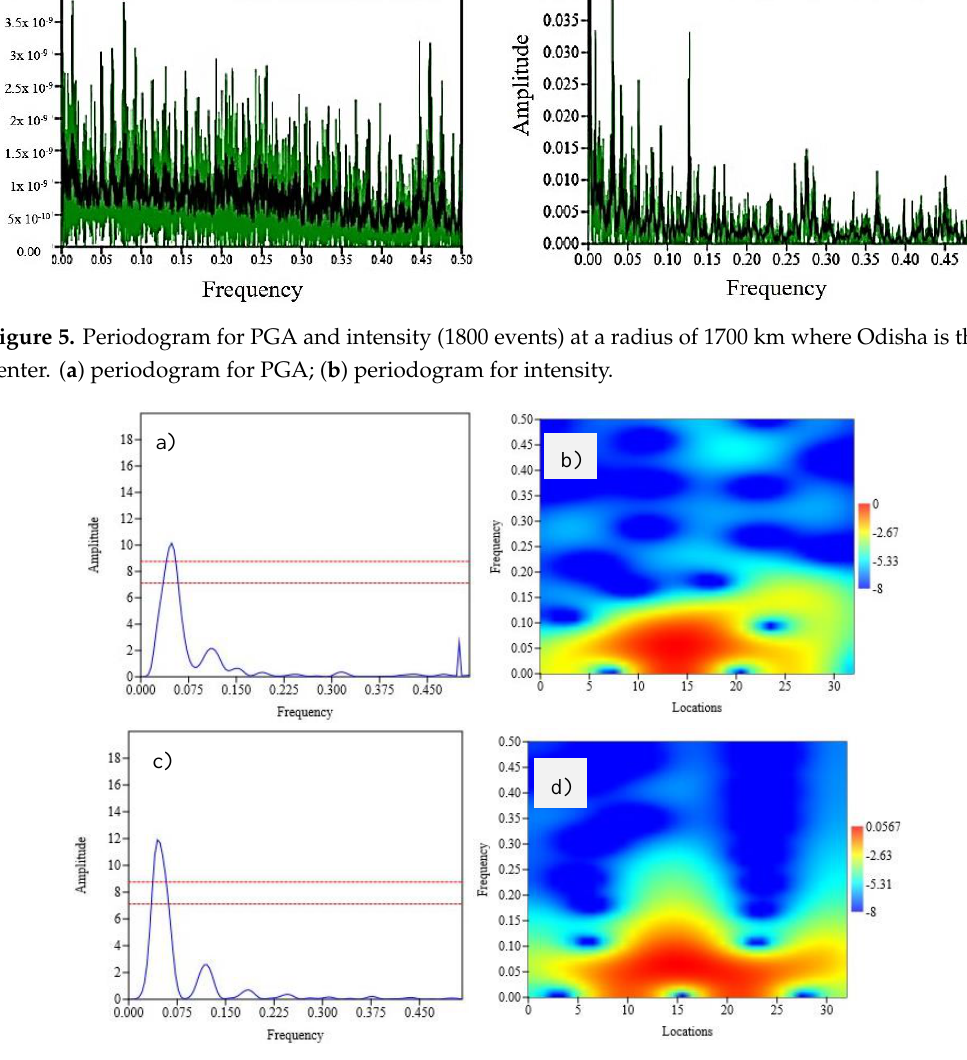
Figure 6. Short time Fourier transform (STFT) analysis for PGA and intensity in Odisha. ( a ) Periodogram for PGA in Odisha, ( b ) STFT simulation for PGA, ( c ) periodogram for intensity in Odisha, and ( d ) STFT simulation for intensity. (Frequency: Hz and amplitude: m). Red amplitude levels were plotted to mark the highest peak. PGA (0–0.53 g) and intensity (II to VI) variations were observed in Odisha. Periodogram of the